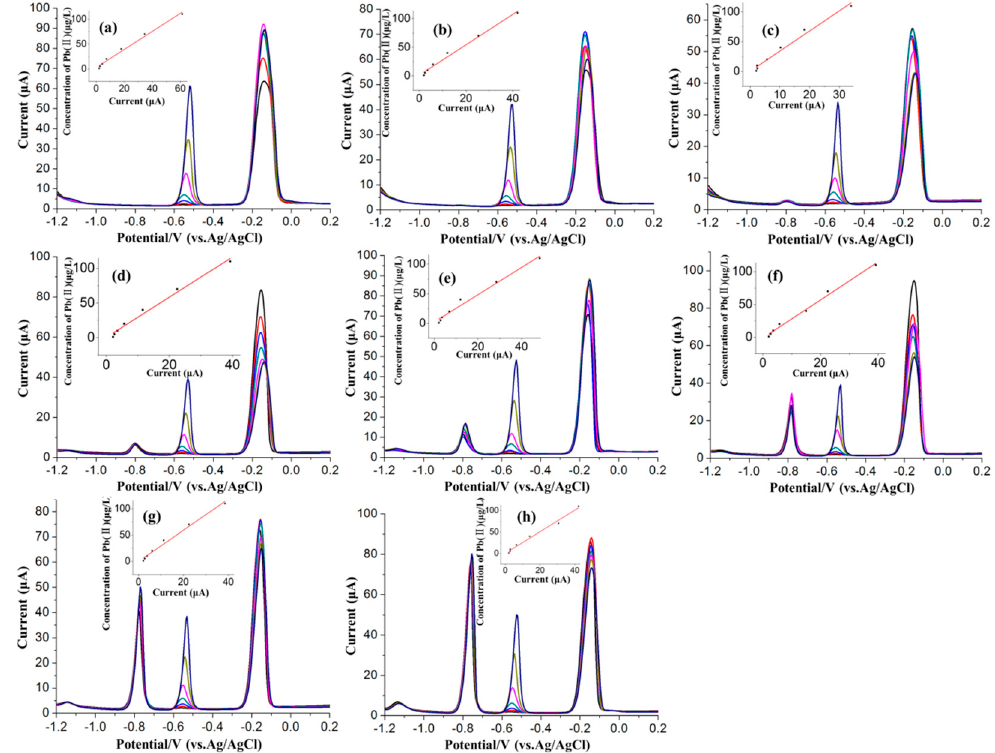
Figure 4. Voltamogrames for Pb(II) ranged from 1.0 to 110 μ g/L in different concentrations of Cd(II) ranged from 0 to 110 μ g/L: ( a ) 0 μ g/L; ( b ) 1 μ g/L; ( c ) 5 μ g/L; ( d ) 10 μ g/L; ( e ) 20 μ g/L; ( f ) 40 μ g/L; ( g ) 70 μ g/L; ( h ) 110 μ g/L. Deposition time: 140 s. Deposition potential: − 1.2V. Concentration of Bi(III): 600 μ g/L.